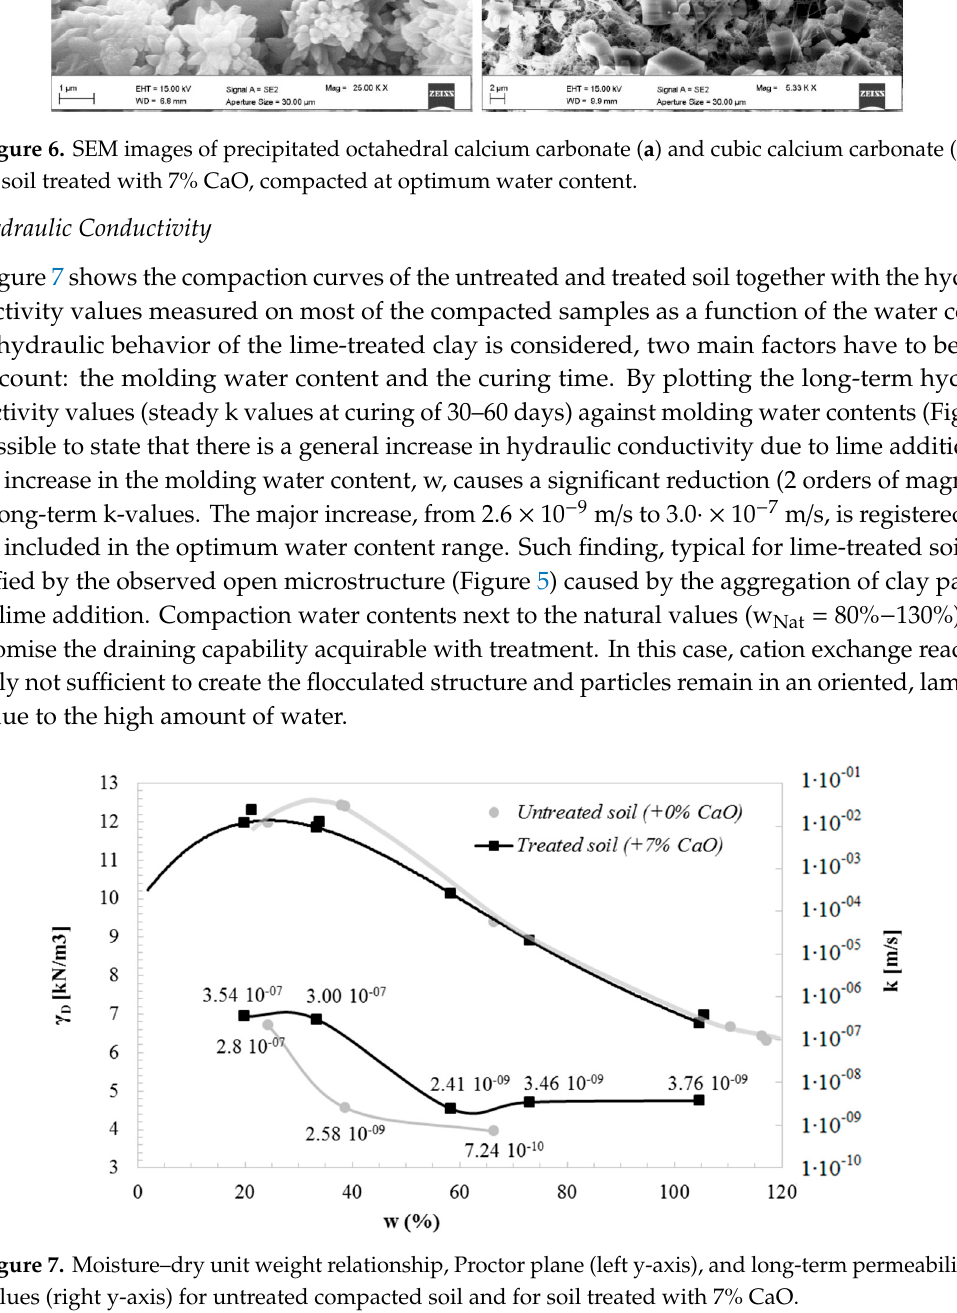
Figure 6. SEM images of precipitated octahedral calcium carbonate ( a ) and cubic calcium carbonate ( b ) in soil treated with 7% CaO, compacted at optimum water content.